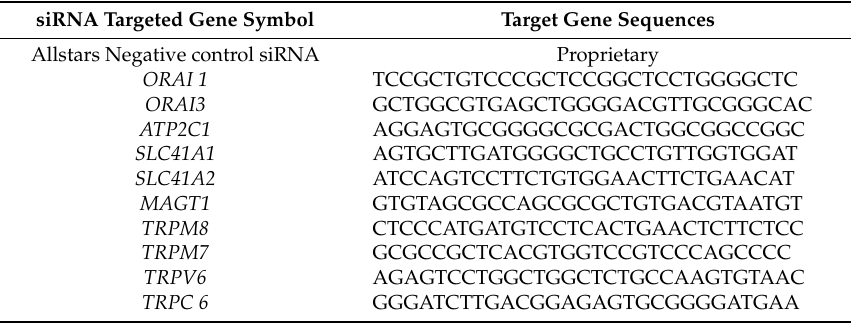
Table 2. siRNA and their targeted gene sequences as sourced by